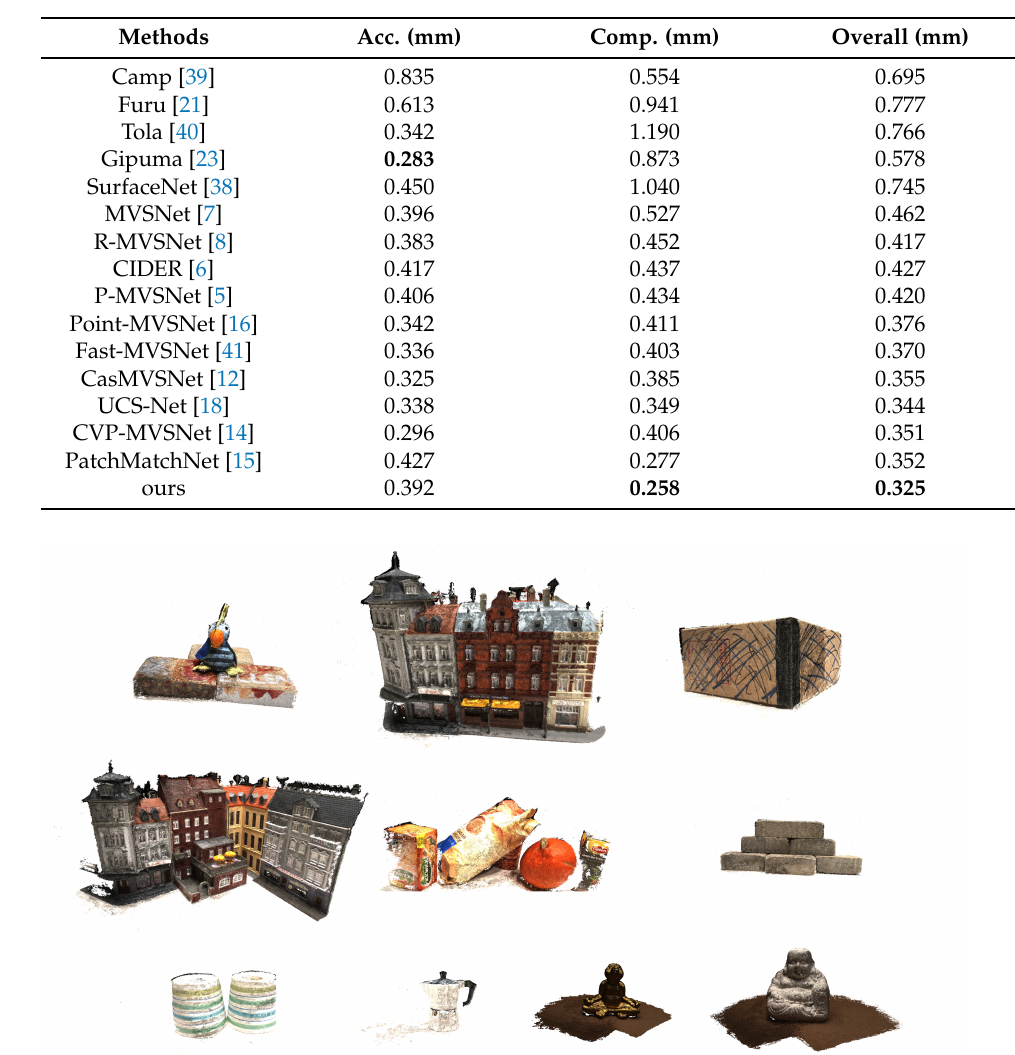
Figure 4. Reconstruction results on a partial evaluation set of DTU